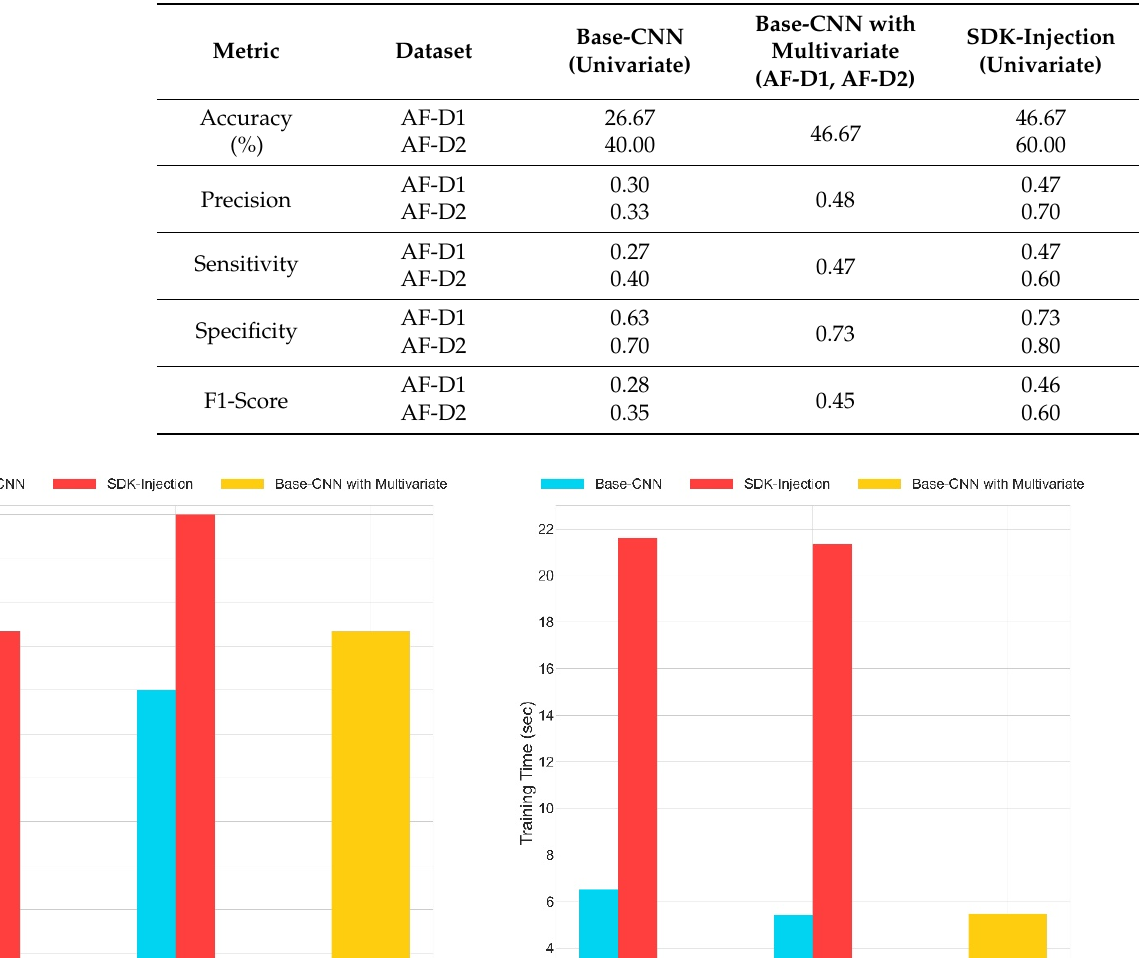
Table 4. Performance evaluation of univariate Base-CNN, multivariate Base-CNN, and SDK-Injection.